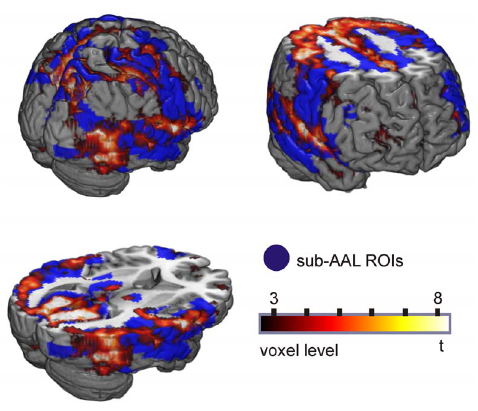
Figure 2. Brain regions with high degree centrality in controls. Shown are the results from voxel-level (red to white scale) and ROI-level (blue)